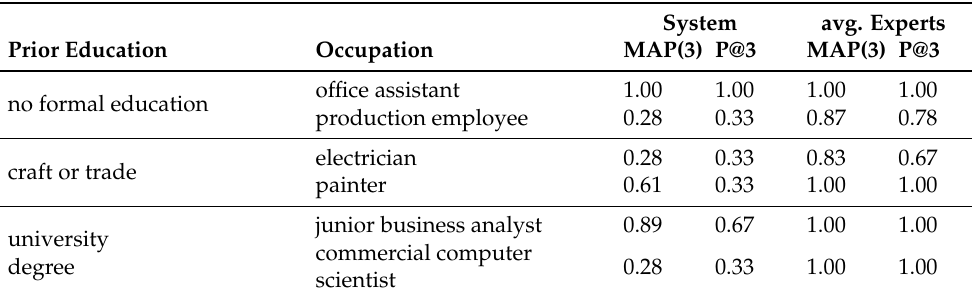
Table 7. Mean average ranking performance, precision, and average expert agreement for the career path